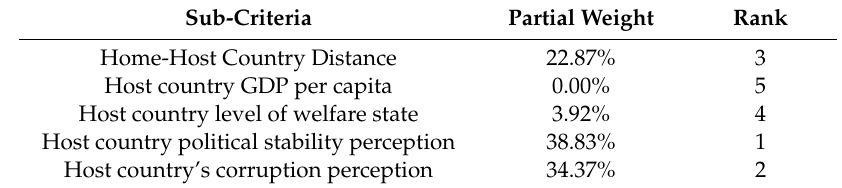
Table 7. Sub-criteria relative weight and rank of characteristics of the city’s host country or region.